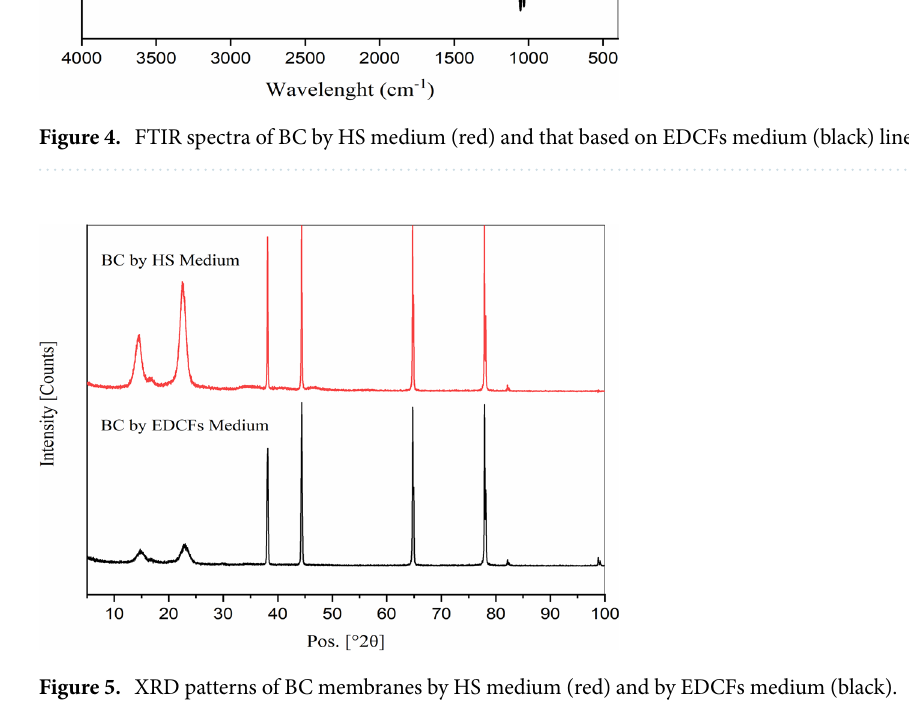
Figure 5. XRD patterns of BC membranes by HS medium (red) and by EDCFs medium (black).